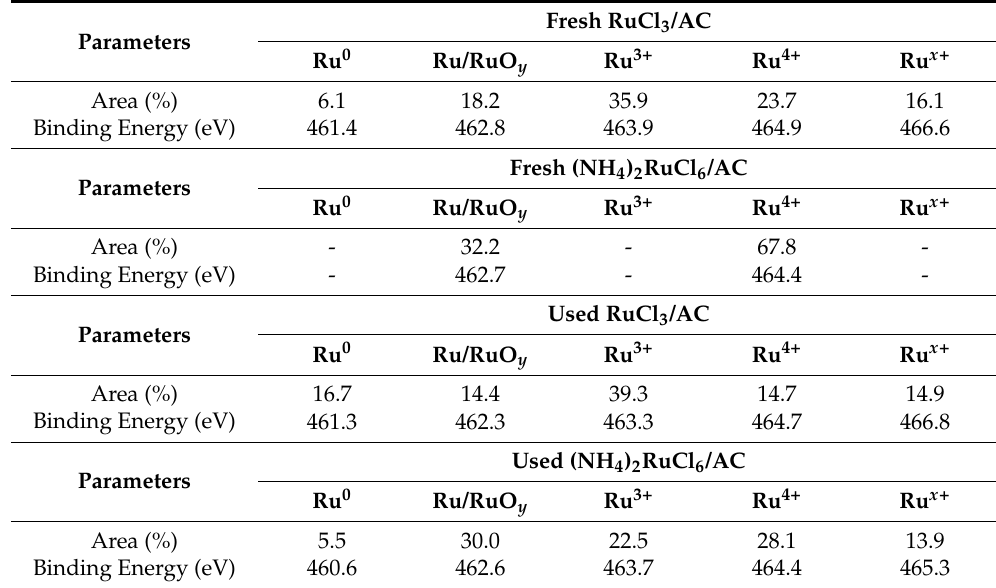
Table 3. The relative contents and binding energies of Ru species in the fresh and used catalysts with 1.0 wt % Ru